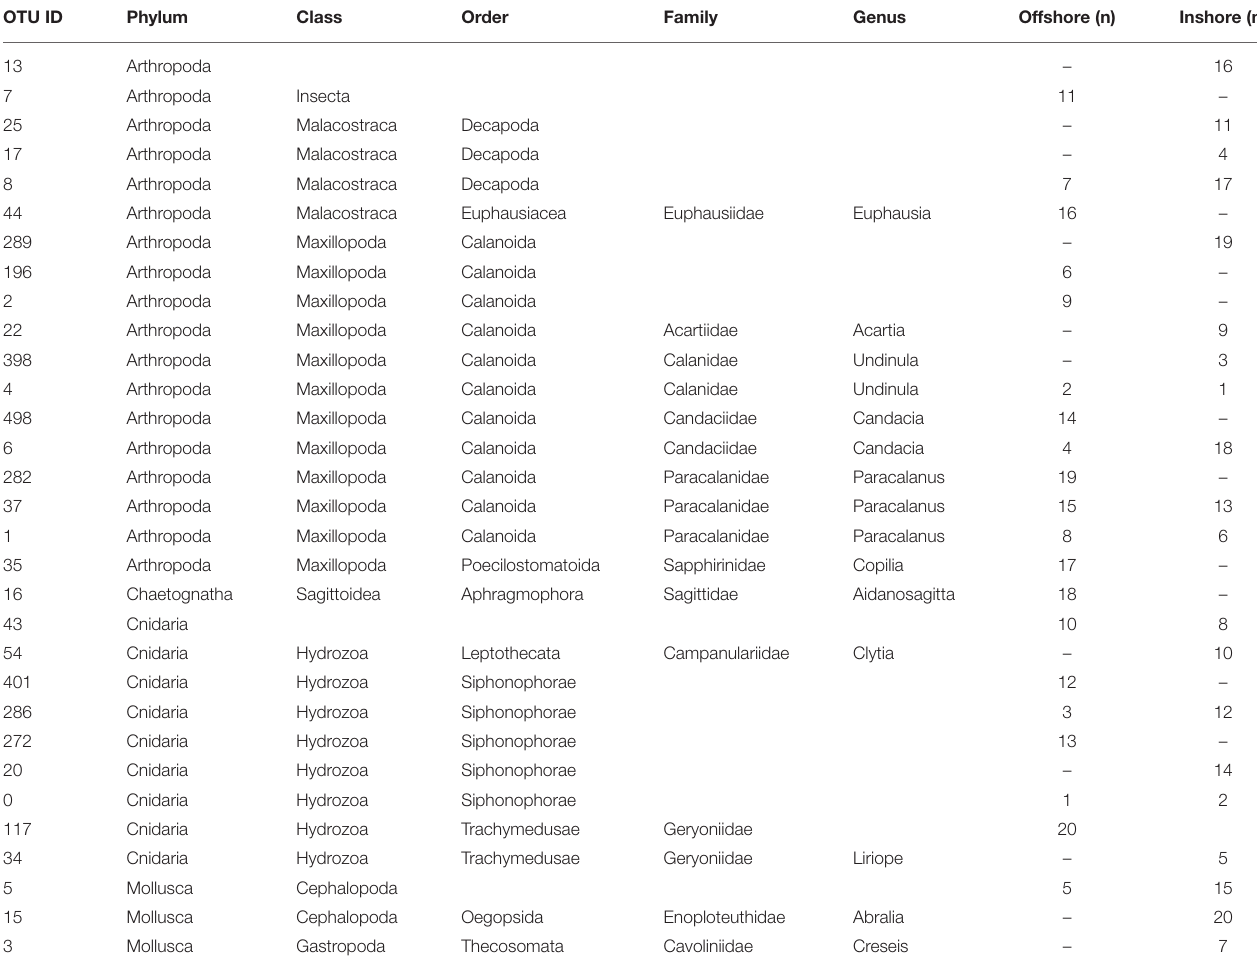
TABLE 1 | Compilation of the top 20 OTUs in terms of abundance for the epipelagic zooplankton community inhabiting the top 100m of the water column identified in the inshore and offshore stations (n, where n indicates percentage of reads). OTU